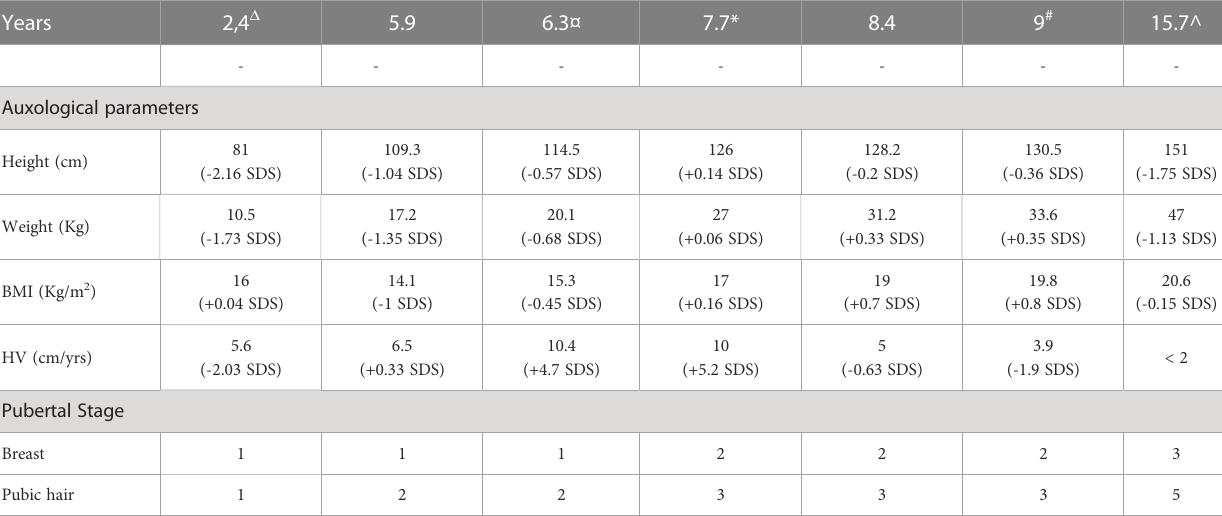
TABLE 1 Clinical features during endocrinological follow